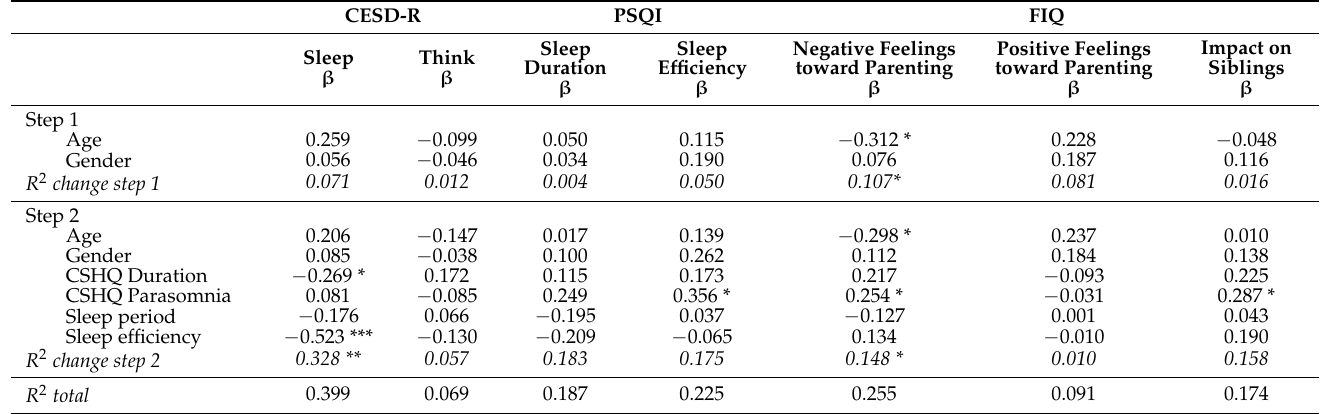
Table 4. Predicting family functioning from child